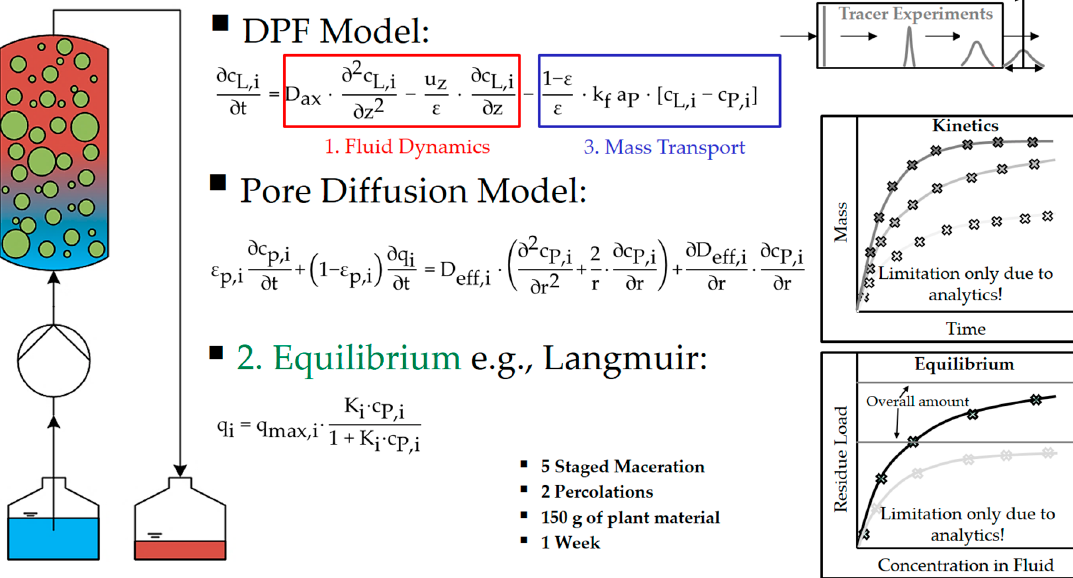
Figure 7. Equation assembly for experimental model parameter determination.